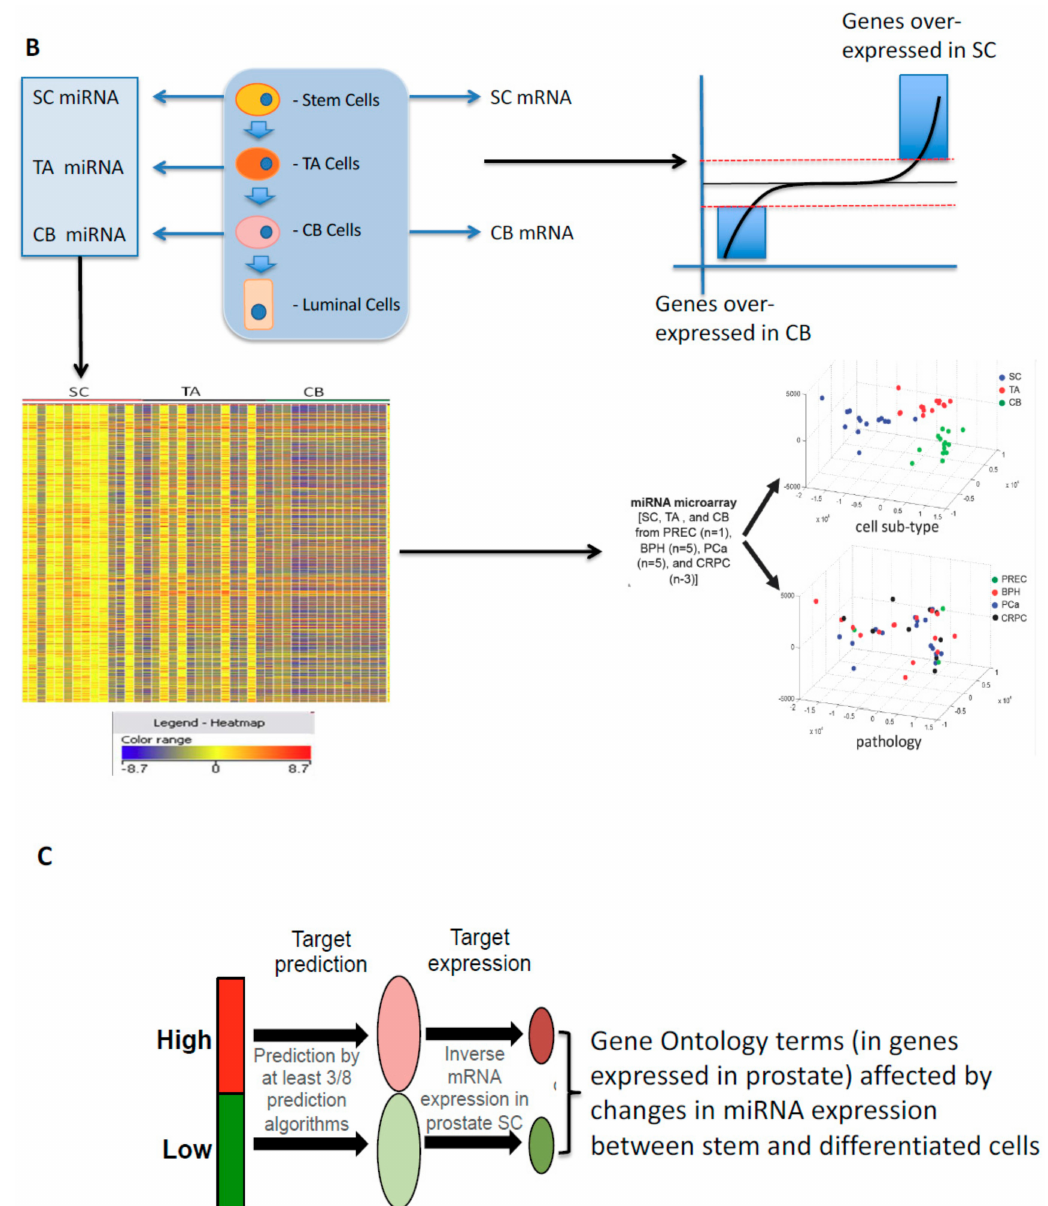
Figure 2. Strategies to categorize the genes and miRNAs which modulate prostate epithelial di ff erentiation. ( A ) mRNA co-expression analysis in the transition from SC to CB (committed basal) cells in human prostate epithelial cells [26]. Clustering reveals gene pairs which always change together, in this transition and in other cell systems. Note the lack of overlap between the various gene clusters, implying a common control system for each cluster. Selected individual genes are listed in Tables 1 and 2. Identification of individual genes is possible by zooming in electronically on the figure. ( B ) miRNA expression datasets were generated from di ff erent cell populations from prostate tissues with a variety of pathologies [27]. Unsupervised clustering of the miRNA database indicated that miRNA expression was more closely correlated to di ff erentiation that normal / benign / cancer tissues. Note (lower right panel) the high expression of miRNA (warm color) in the SC, which decays in the TA population, with increasing downregulation (shown as blue) as the cells become more di ff erentiated (CB cells) and begin to express a wider and more specialized mRNA set. ( C ) Gene ontology strategy to relate miRNA expression to that of mRNA known to be expressed in the various prostate epithelial cell types